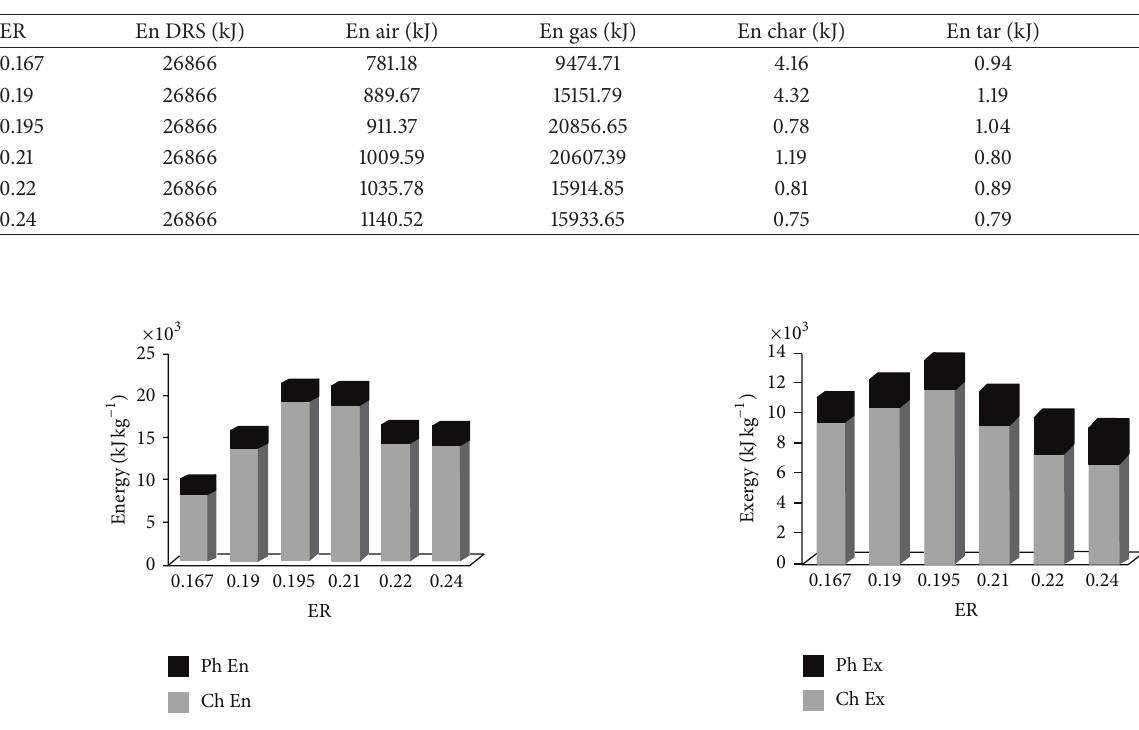
Table 3: Effect of ER on energy balance and its closure.